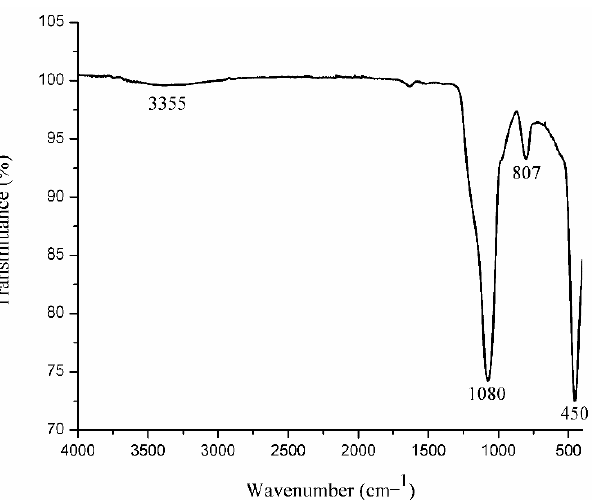
Figure 3. IR spectrum of the SiO 2 -Gd 2 O3:Eu 3+ (1%) nanoparticles, displaying the typical absorption bands of this material.